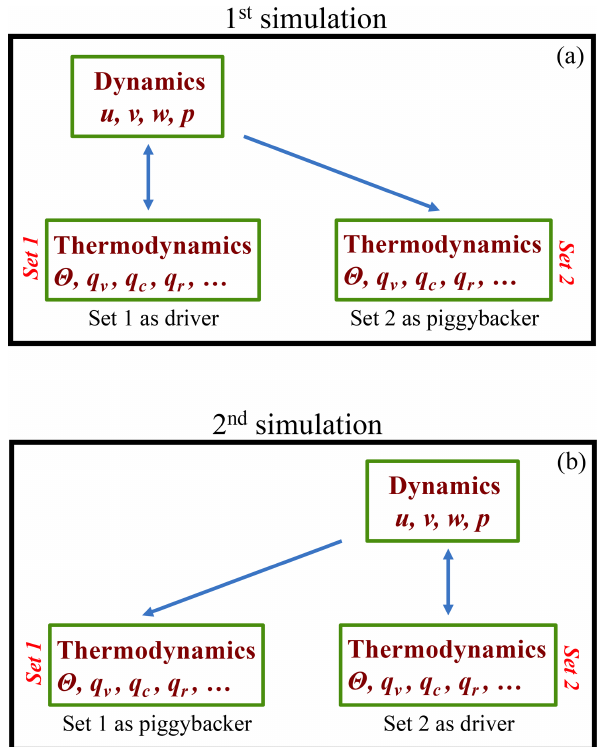
Figure 1. The schematic of the piggybacking methodology. (a) shows the first simulation in which set 1 of thermodynamic vari- ables drives the simulation and the set 2 piggybacks the simulated flow. This is reversed in (b) , where the second simulation is driven by the set 2 of thermodynamic variables and the set 1 piggybacks the simulated flow. The dynamic variables are the velocity com- ponents u , v , w and pressure p . Thermodynamic variables include the potential temperature θ , water vapor mixing ratio q v , all cloud q c , all precipitation q r , and all other variables that thermodynamics needs (e.g.,